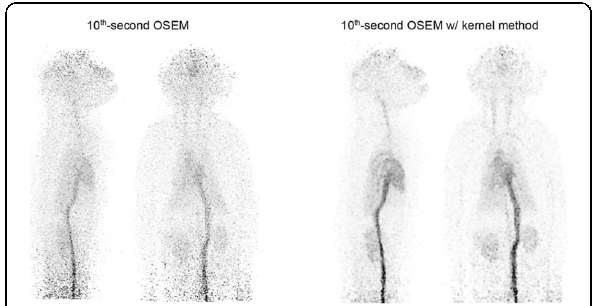
Fig. 1 (abstract A32). Reconstructed images of the primate 18 F-FDG imaging study scanned using the mini-EXPLORER-I. OSEM (left) and kernel (right) reconstruction for the 1-second dynamic PET at the 10 th second post injection. The images are maximum intensity projections